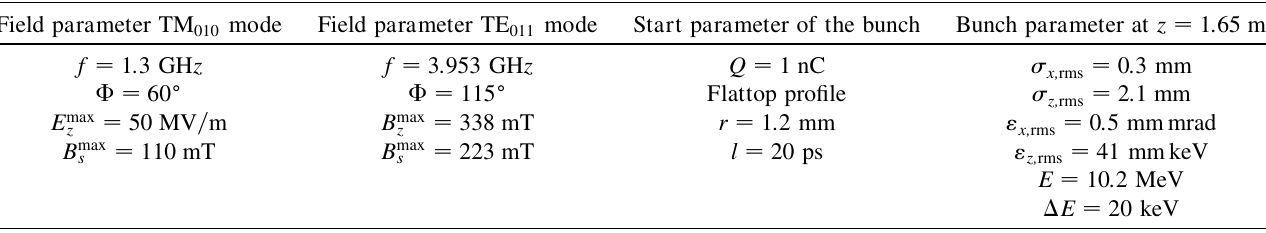
TABLE I. Optimal rf and beam parameters for a superconducting rf gun with an additional magnetic rf field inside the cavity. The amplitude of the magnetic surface field is above the quench limit.